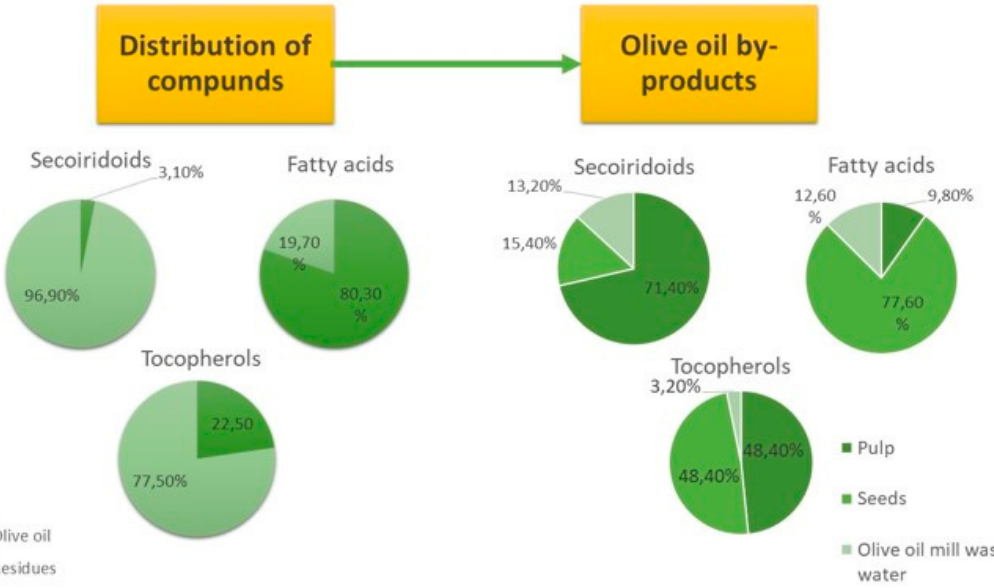
Figure 4. Content of important bioactive compounds of the olive oil and olive oil by-products that can be further used in food industry and medical application [121]. can be further used in food industry and medical application